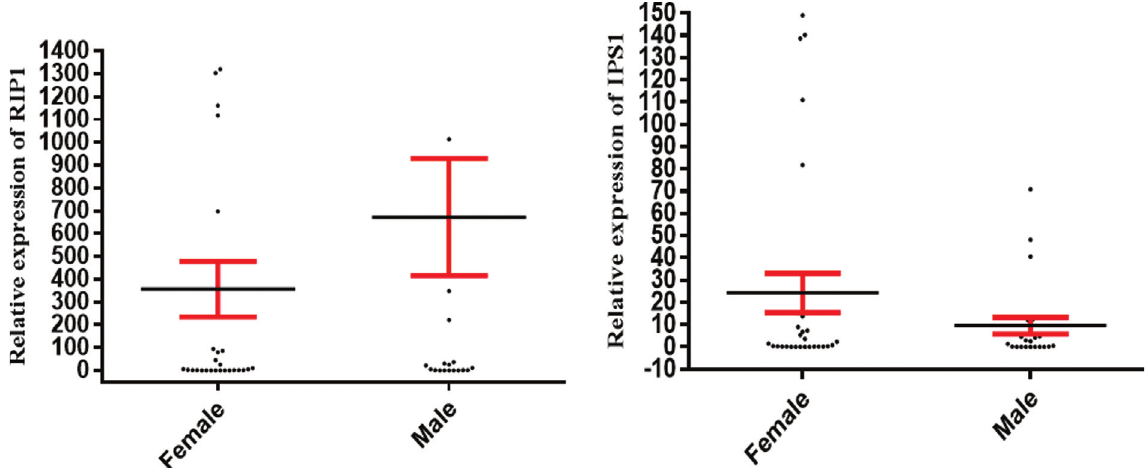
Figure 2 - RIP1 and IPS-1 gene expression in male and female patients with chronic hepatitis B. The figure shows that mRNA levels of IPS-1 and RIP1 did not differ between male and female patients with chronic hepatitis B. Data are presented as mean (cid:4) standard errors. The results regarding the expres- sion levels of IPS-1 and RIP1 are reported as fold-changes (Ebrahim et al. , 2015).